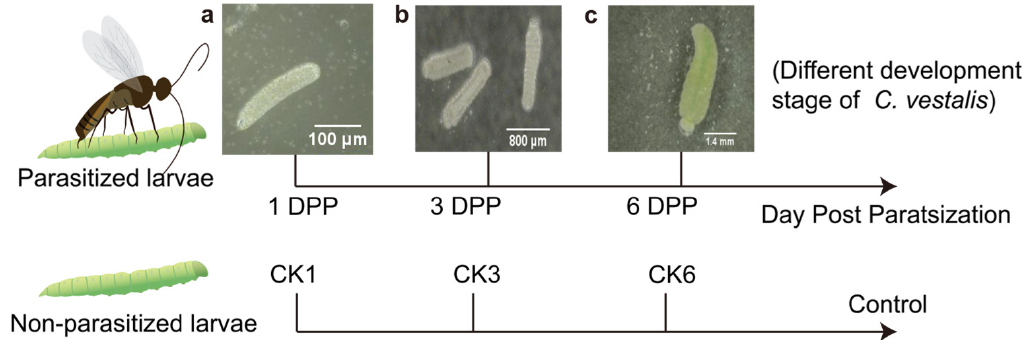
Figure 1. Experimental outline for exploring changes in the gut microbiota of parasitized P. xylostella and non-parasitized P. xylostella . (Different development stages of C. vestalis during sampling. ( a ) egg; ( b ) low instar larva; ( c ) mature larvae).